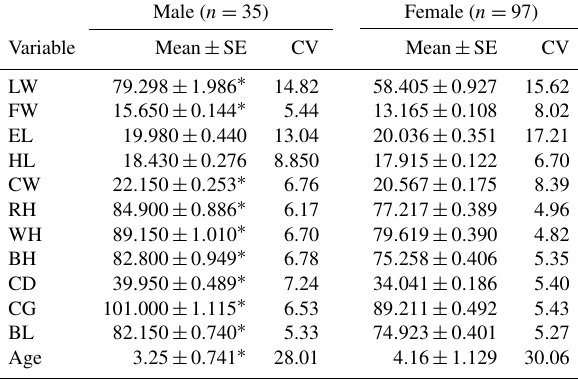
Table 1. Descriptive statistics regarding live weight and some body measurements for male and female